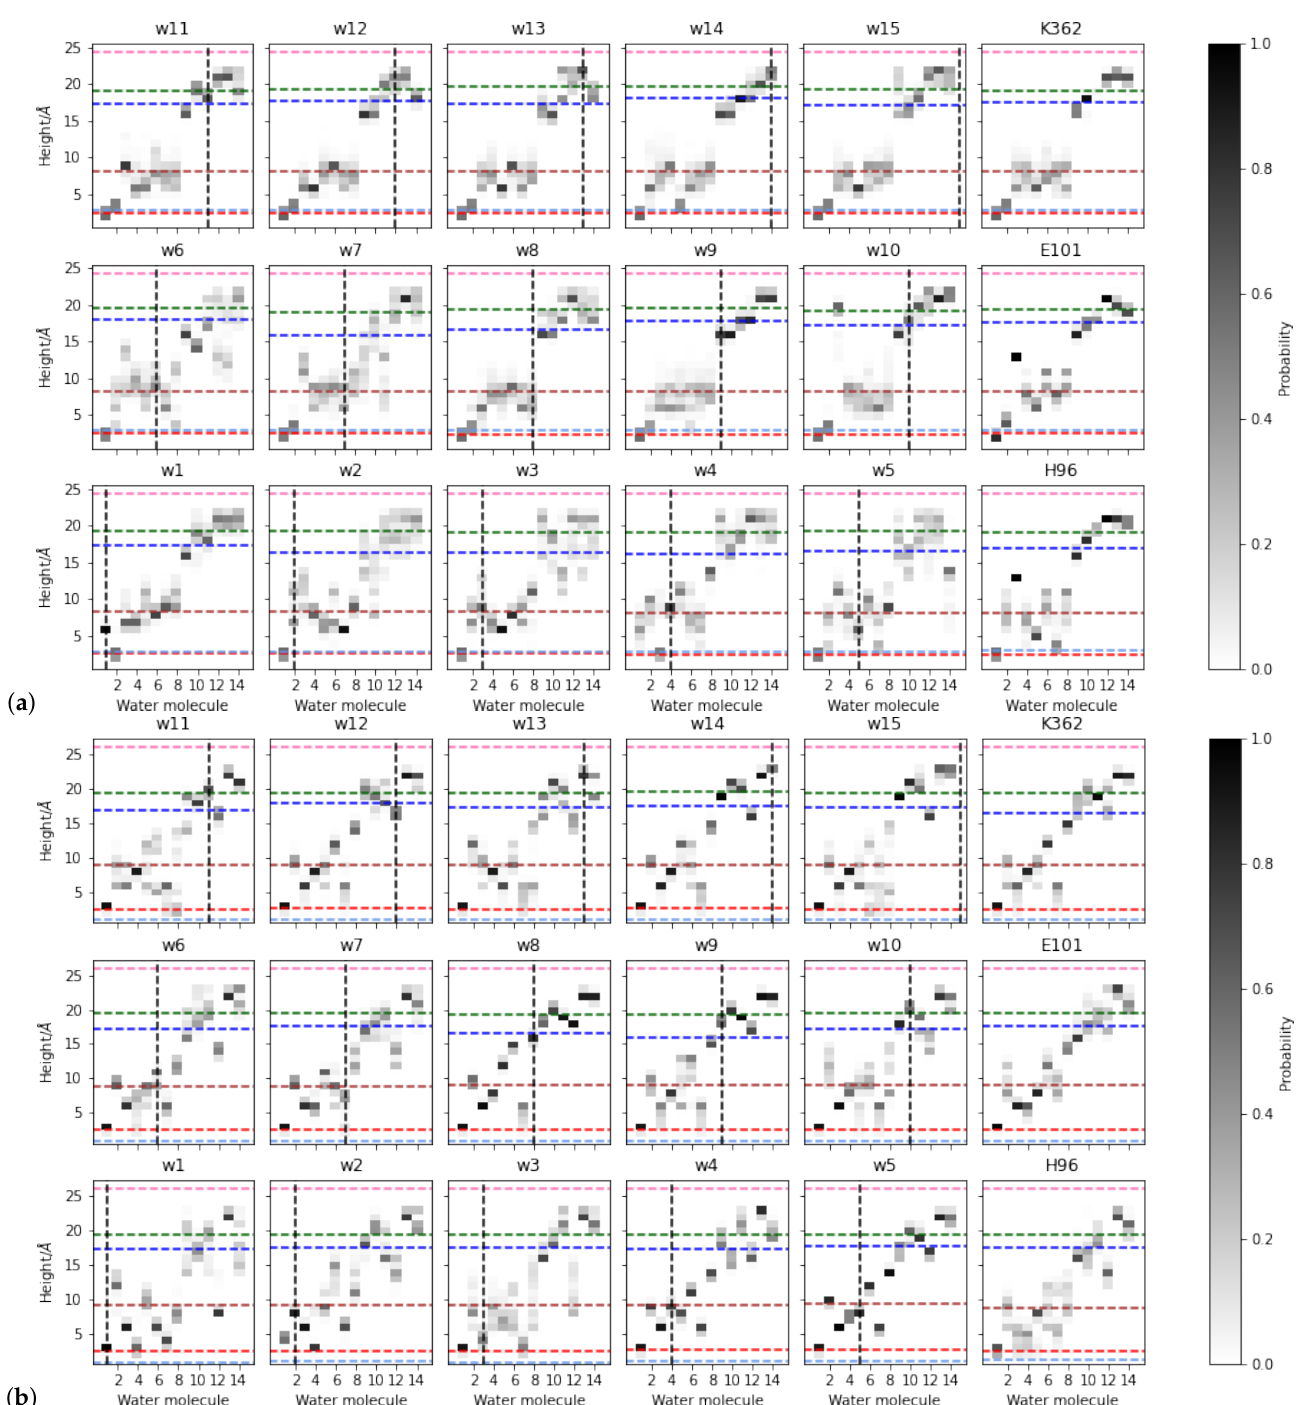
Figure 2. Occupancies of water positions, represented by their height in the K-channel. ( a ) Simulations of the reduced model based on a snapshot with K362 in an “up” position, ( b ) simulations of the reduced model based on a snapshot with K362 in a “down” position. The dashed horizontal lines represent the average height of the hydroxyl oxygen atom of Y288 (pink), the hydroxyl oxygen atom of T359 (green), the nitrogen atom of K362 (blue), the hydroxyl oxygen atom of S365 (brown), the CD atom of E101 (red), and the CE1 atom of H96 (cornflowerblue). The dashed black line marks the water molecule that is protonated in the respective